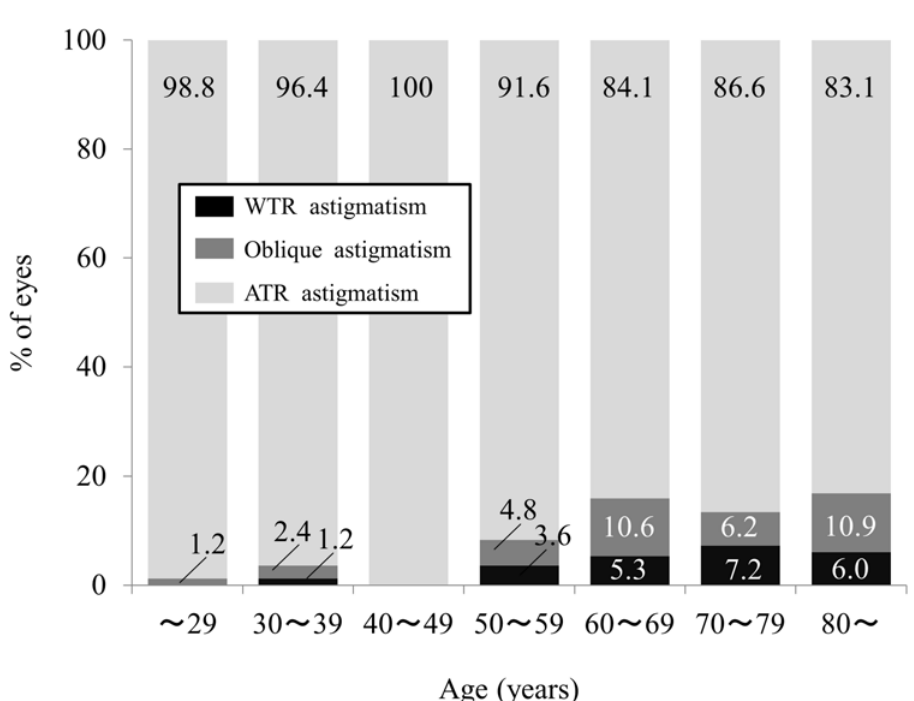
Fig 2. Distribution of posterior corneal astigmatism in each age group.